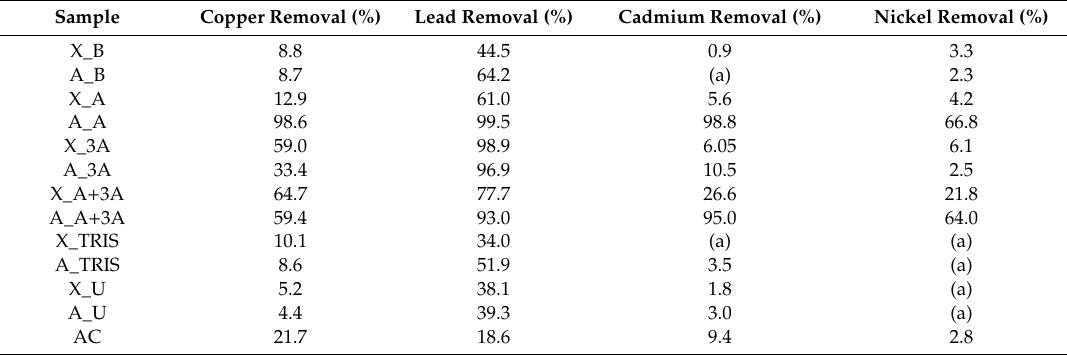
Table 4. Heavy metal removal e ffi ciencies, in percentage, for di ff erent adsorbents. C 0 = 50 mg · L − 1 , pH 5, 20 ◦ C, 24